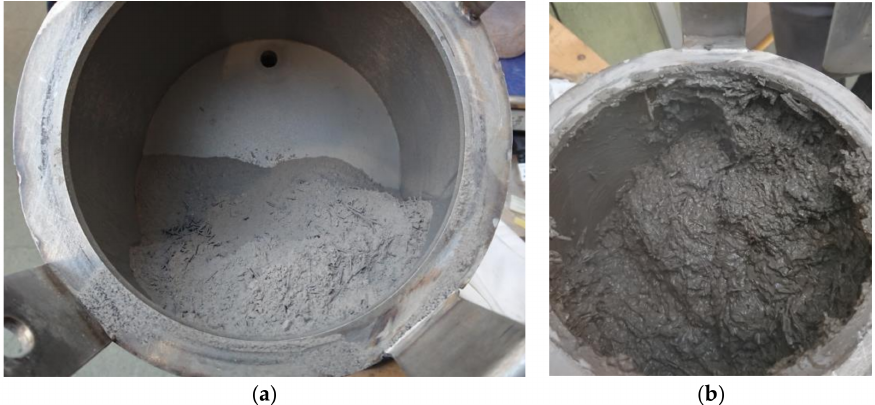
Figure 7. Working chamber during grinding experiments: ( a ) dry grinding; ( b ) wet